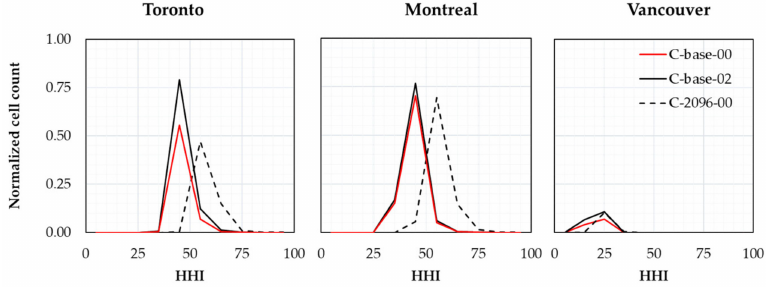
Figure 11. Normalized histograms of HHI (to the maximum count of three cities) of base scenario (C-base-00), the worst case of only the climate change scenario (C-2096-00) and the worst case of only urbanization (C-base-02) for the three cities (Toronto, Montreal, and